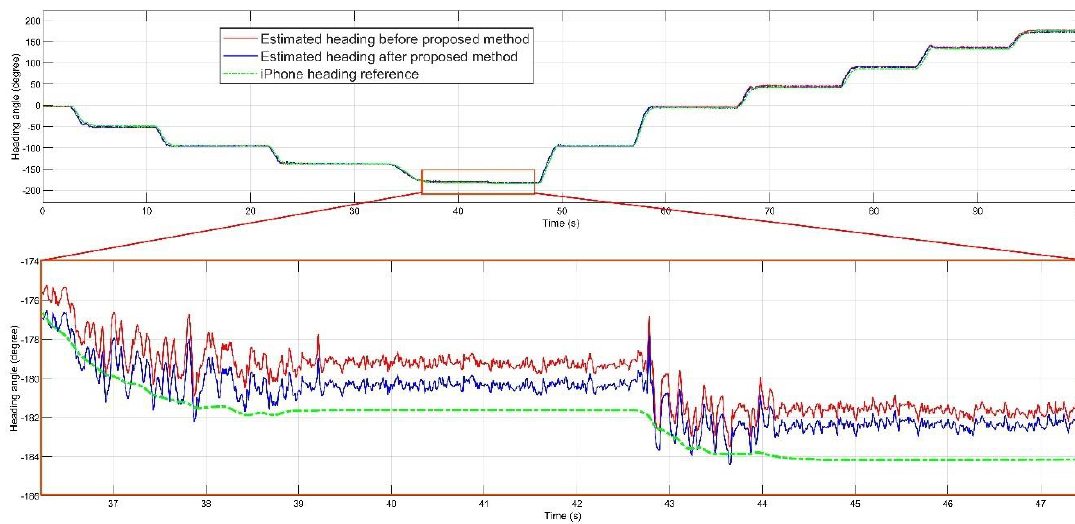
Figure 4. Estimated attitude before and after proposed method compared to the iPhone reference: ( a )